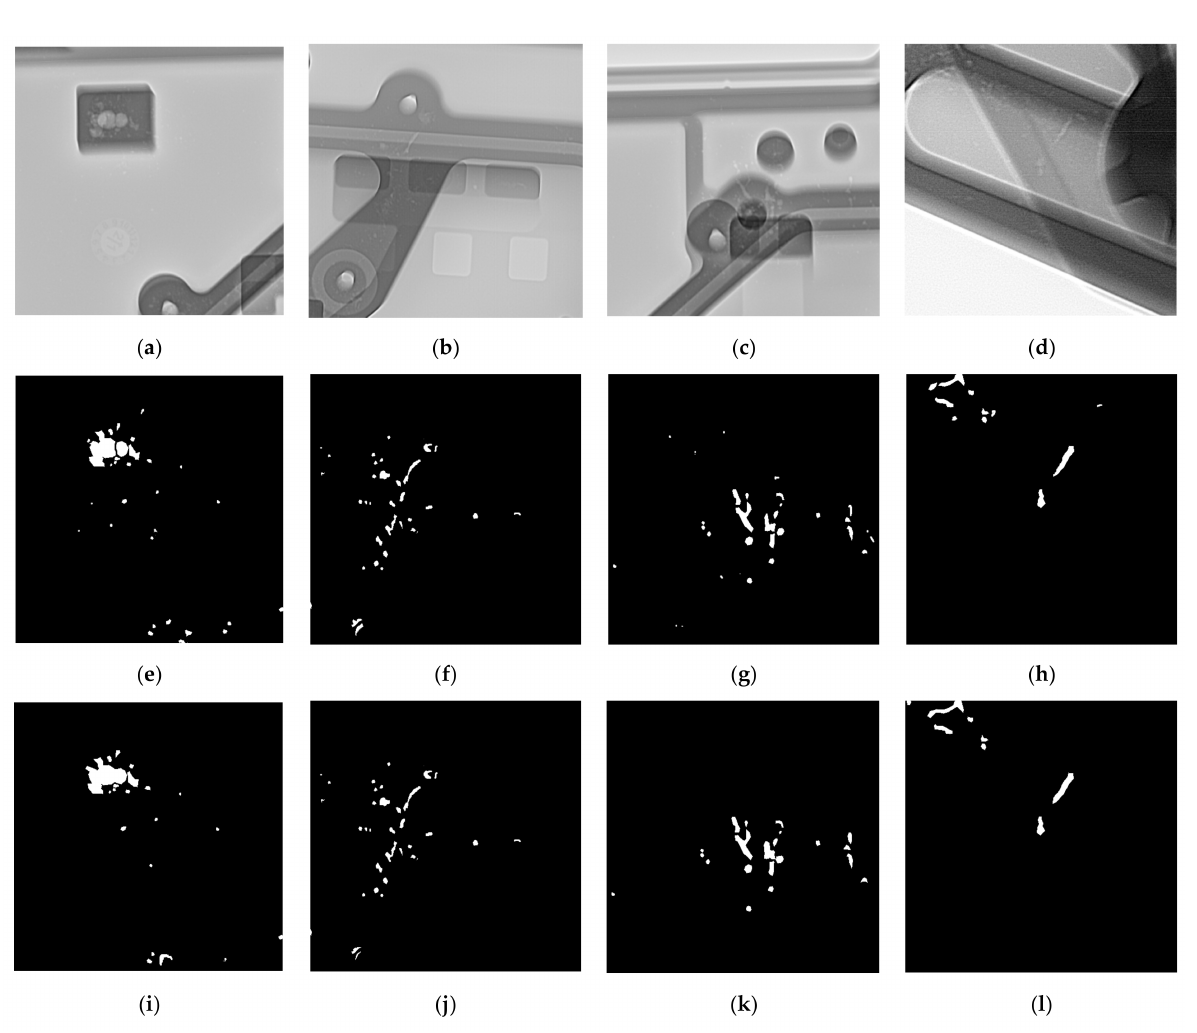
Figure 12. Segmentation examples of proposed method. ( a – d ) are the original images; ( e – h ) are the ground-truth images; ( i – l ) are the corresponding segmentation results.